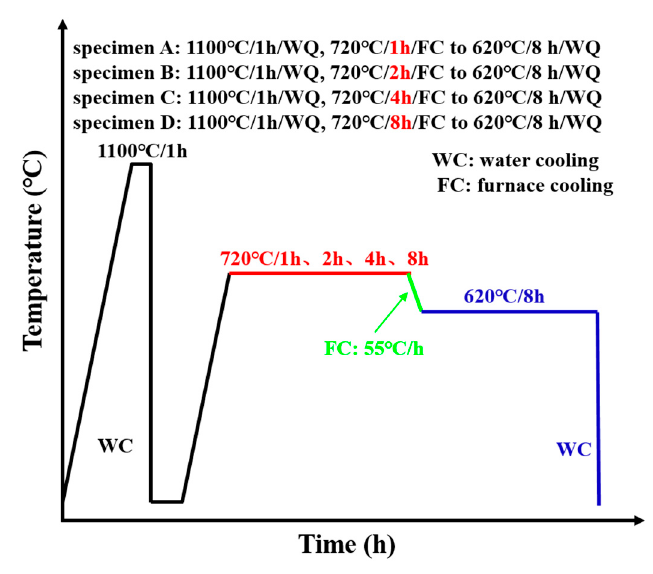
Figure 1. Specific details of the heat treatment process.